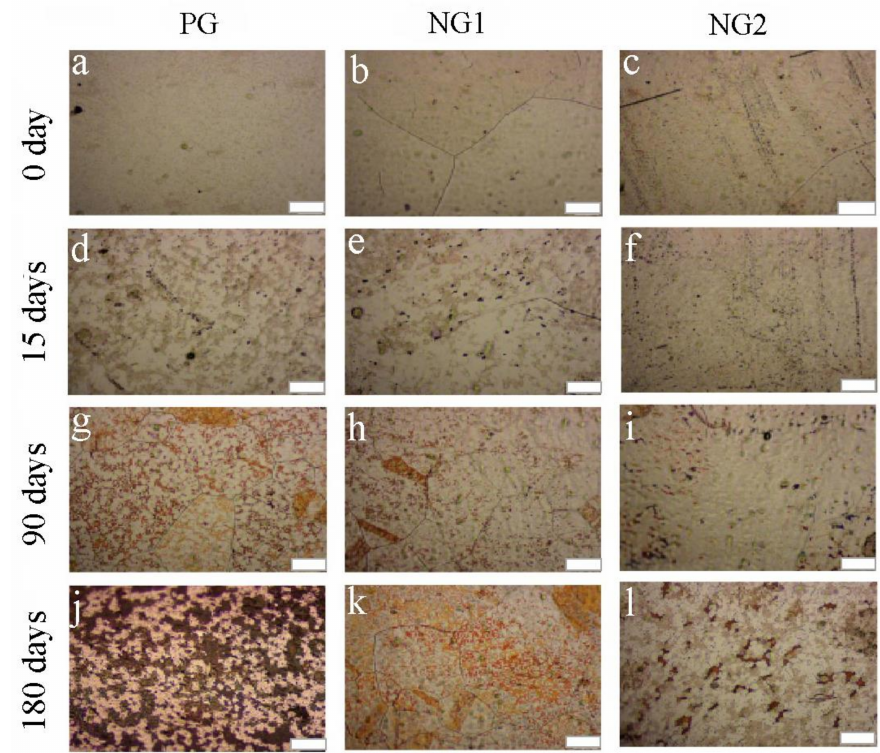
Figure 4. OM of the samples after exposure in air. ( a – c ) OM of PG-, NG1-, and NG2-covered Cu freshly prepared, respectively; ( d – f ) OM of PG-, NG1-, and NG2-coated Cu left in the ambient for 15 days, respectively; ( g – i ) OM of PG-, NG1-, and NG2-coated Cu left in the ambient for 90 days, respectively; ( j – l ) OM of PG-, NG1-, and NG2-coated Cu left in the ambient for 180 days, respectively. Scalebar is 20 µ m. These photos were taken under uniform exposure